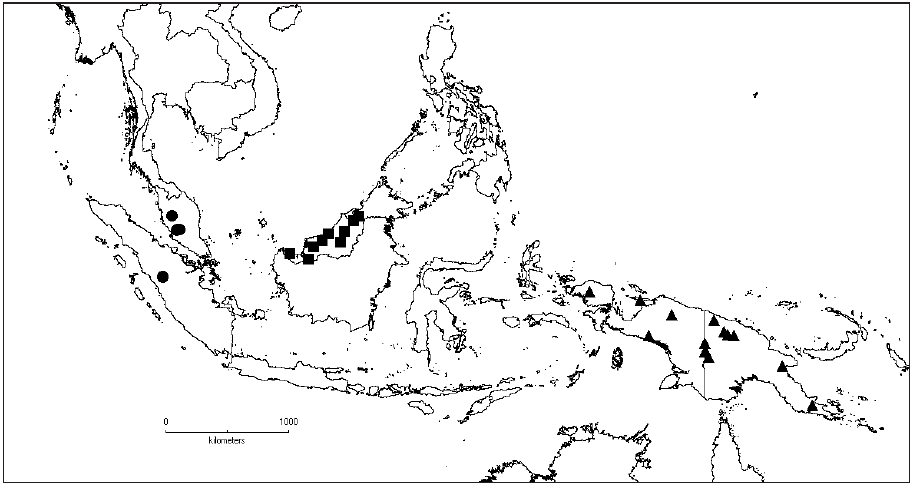
Map 26. Distribution of D. sarawakensis ( ■ ), D. schumannii ( ▲ ) and D. spectabilis ( ●